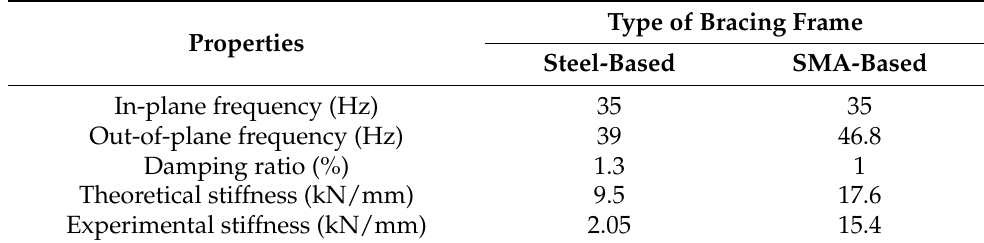
Figure 14. ( a ) Bracing frame with steel-based yielding fuse; ( b ) bracing frame with SMA-based yielding fuse [69]. Table 4. A comparison between the steel-based and SMA-based bracing systems